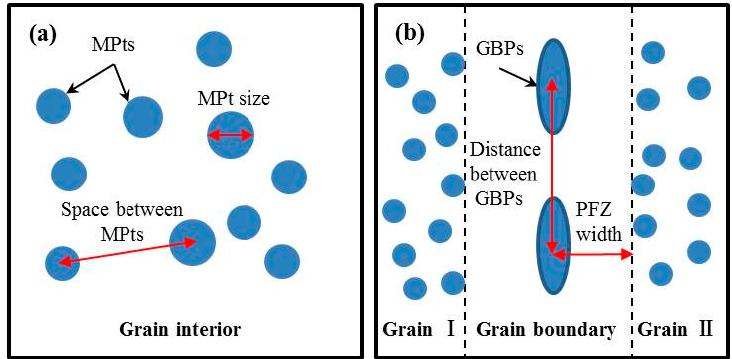
Figure 3. The sketch map of the microstructures of the typical Al ‐ Zn ‐ Mg ‐ Cu alloy: ( a ) grain interior area of the field of view, FW GI ; ( b ) grain boundary area of the field of view, FW GB .